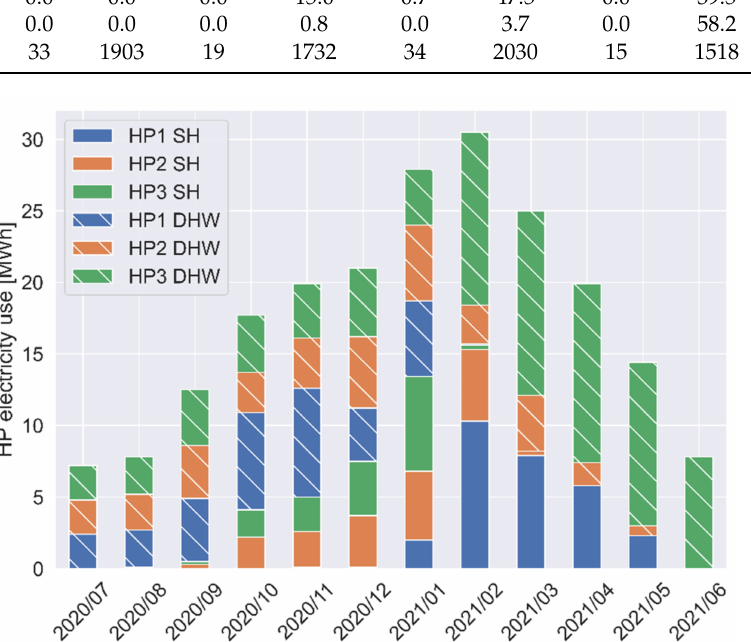
Figure 17. Heat pumps: monthly electricity use in space heating (SH) and domestic hot water (DHW)